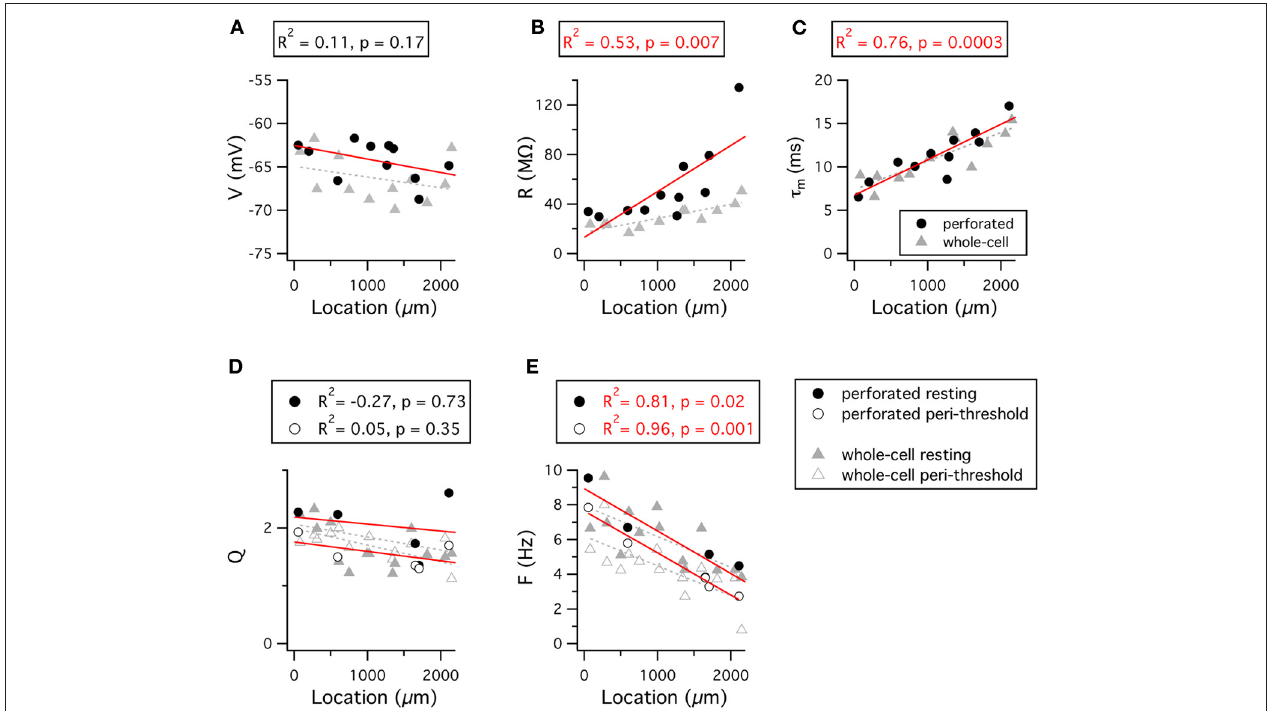
and significance of the fit for the perforated patch-clamp data are stated above each plot. The R 2 and significance values for fits of the whole-cell data are as follows: V , R 2 = 0 . 04, p = 0 . 24; R , R 2 = 0 . 59, p = 0 . 0009; τ m , R 2 = 0 . 64, p = 0 . 0003; Q rest , R 2 = 0 . 22, p = 0 . 052; Q peri , R 2 = 0 . 006, p = 0 . 32; F rest , R 2 = 0 . 46, p = 0 . 005; F peri , R 2 = 0 . 5, p = 0 . 003. Location refers to distance from the dorsal border of the